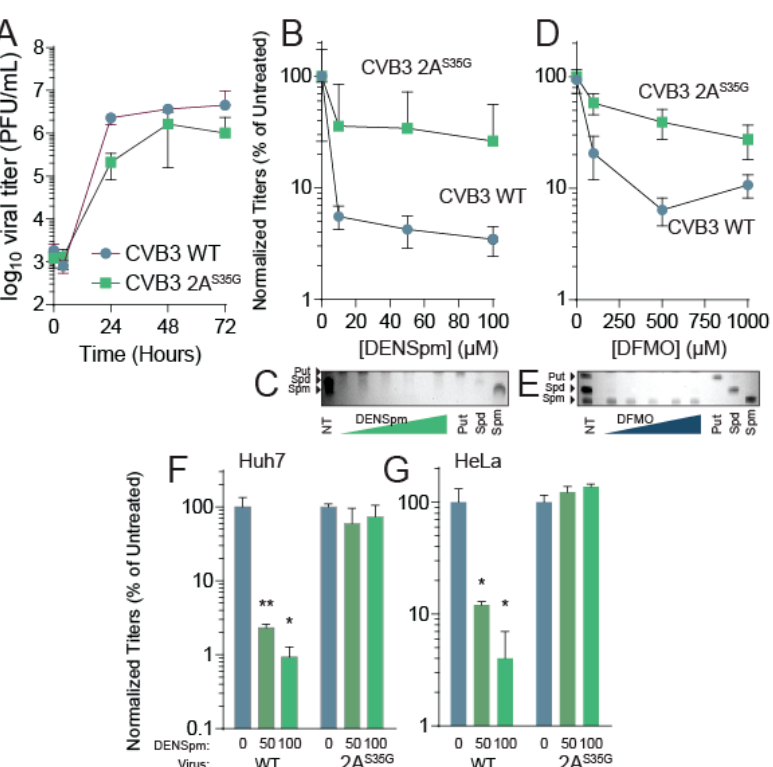
Figure 3. CVB3 2A S35G confers resistance to DENSpm. ( A ) Vero cells were left untreated and were infected with CVB3 and 2A mutant protease at an MOI of 0.1. Samples were collected every 24h and titered via plaque assay. ( B ) Vero cells were treated with increasing doses of DENSpm, from 10 µ M to 100 µ M, for 16 h prior to infection with wildtype CVB3 or 2A protease mutant. Viral titers were determined via plaque assay at 48 hpi. Viral titers were used to calculate the percent replication in DENSpm, by dividing the titer of the virus after infection of DENSpm-treated cells by the titer of the virus after infection of untreated cells at 48 hpi. ( C ) Thin layer chromatograms resolving the polyamines putrescine (Put), spermidine (Spm), and spermine (Spm) after treatment with DENSpm. Arrows indicate the band corresponding to each polyamine. ( D ) Vero cells were treated with increasing doses of DFMO, from 100 µ M to 1 mM, for 4 days prior to infection with wildtype CVB3 or 2A protease mutant. Viral titers were determined via plaque assay at 48 hpi. Viral titers were used to calculate the percent replication in DFMO, by dividing the titer of the virus after infection of DFMO-treated cells by the titer of the virus after infection of untreated cells at 48 hpi. ( E ) Thin layer chromatograms resolving the polyamines putrescine (Put), spermidine (Spm), and spermine (Spm) after treatment with DFMO. ( F ) Huh7 cells and ( G ) HeLa cells were treated with increasing doses of DENSpm and infected with WT or 2A protease mutant as in ( B ). * p ≤ 0.05, ** p ≤ 0.01 using Student’s t -test ( n ≥ 2), comparing treated samples to untreated controls. Error bars represent ± 1 SEM.